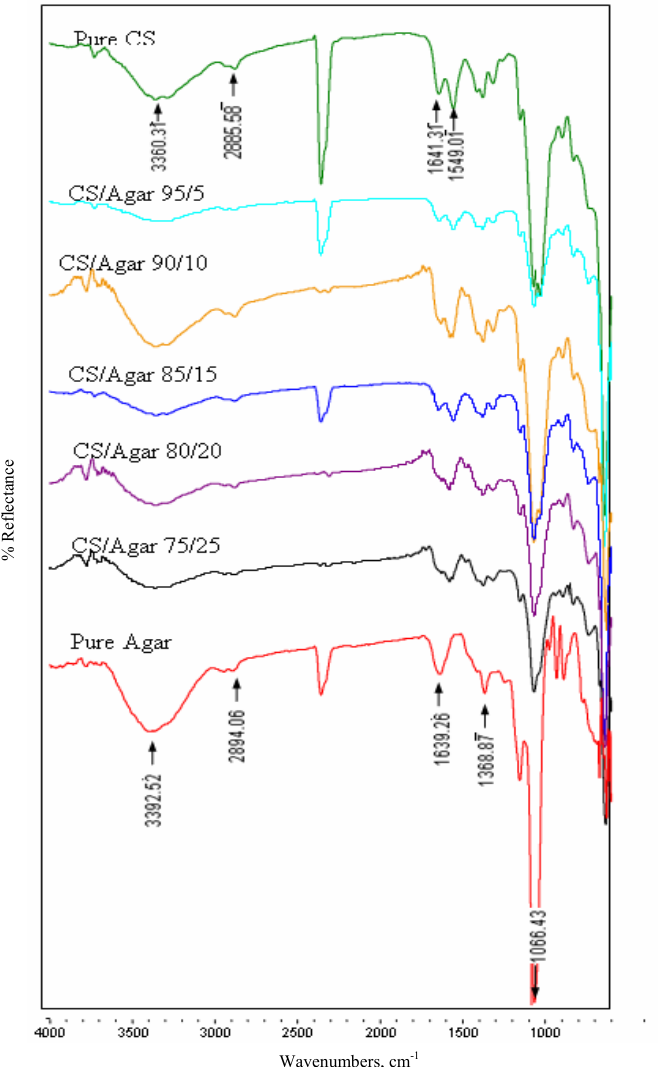
Figure 4. FTIR-ATR spectra of pure agar, pure chitosan and their blended films at various agar